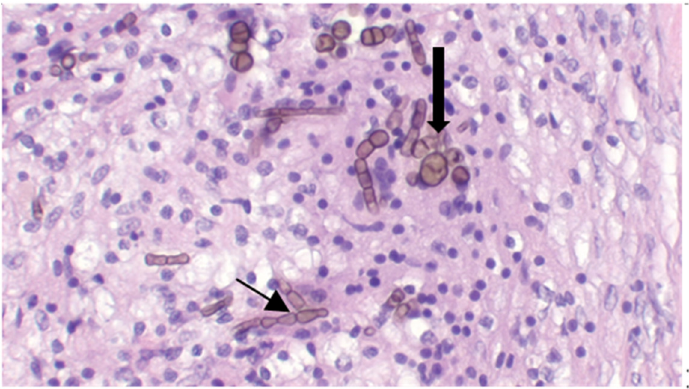
Figure 5. Histopathological examination: diffuse granulomatous inflammation, pigmented fungal hyphae (thin arrows) and muriform bodies (thick arrows) ×40 H&E.